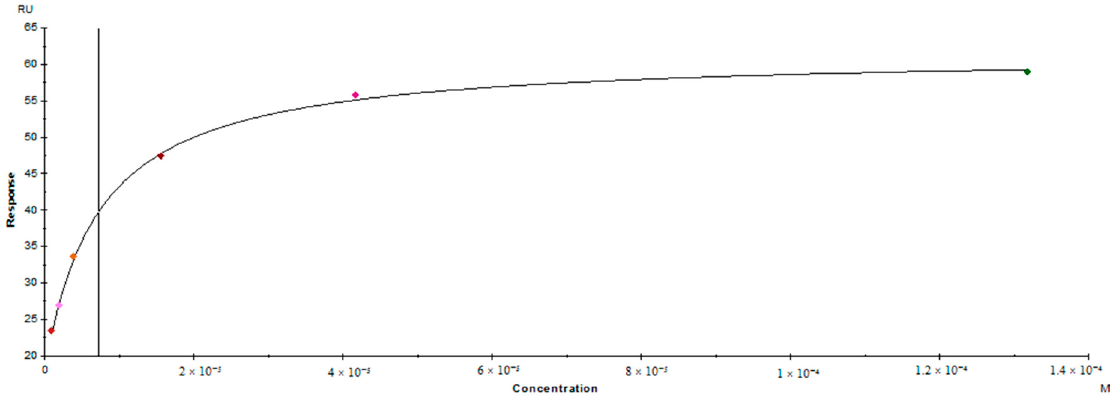
Figure 5 . Steady state affinity model obtained of NS-1502 with KAT-2 at 25 °C. Figure 5. Steady state affinity model obtained of NS-1502 with KAT-2 at 25 ˝